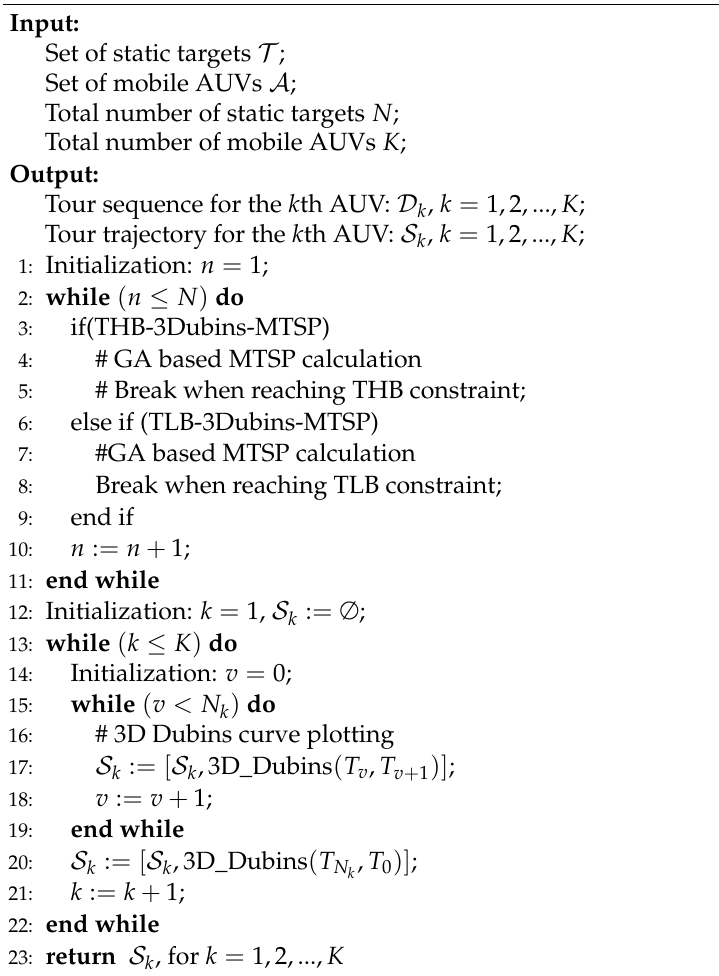
Algorithm 1 The pseudo-code of the proposed